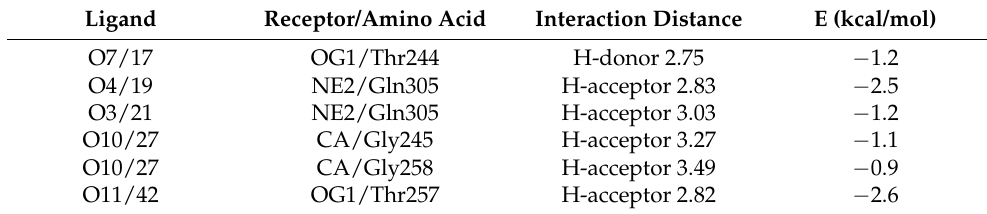
Table 2. Interaction analysis of ligand with target EFLec .